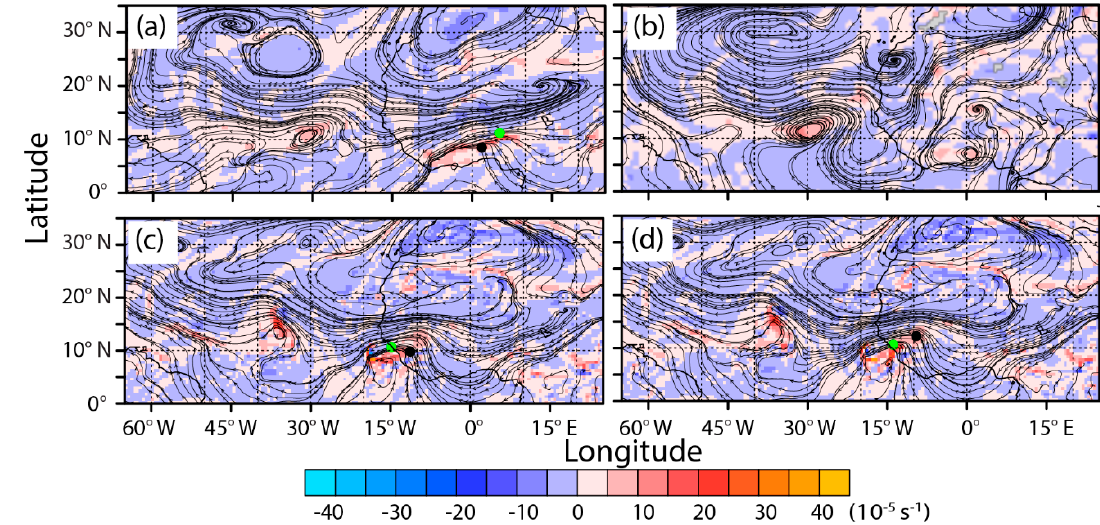
Figure 12. Streamline and relative vorticity (shading, 10 − 5 s − 1 ) from ExDO at ( a ) 600 hPa and ( b ) 850 hPa at 1200 UTC 21 August 2010. Same fields from ( c ) ExDO and ( d ) ExO at 600 hPa at 000 UTC 23 August 2010. The black dots indicate the positions of the local maximum relative vorticity at the trough at 600 hPa, and the green dots indicate the positions of the local maximum wind around the trough at 600 hPa.